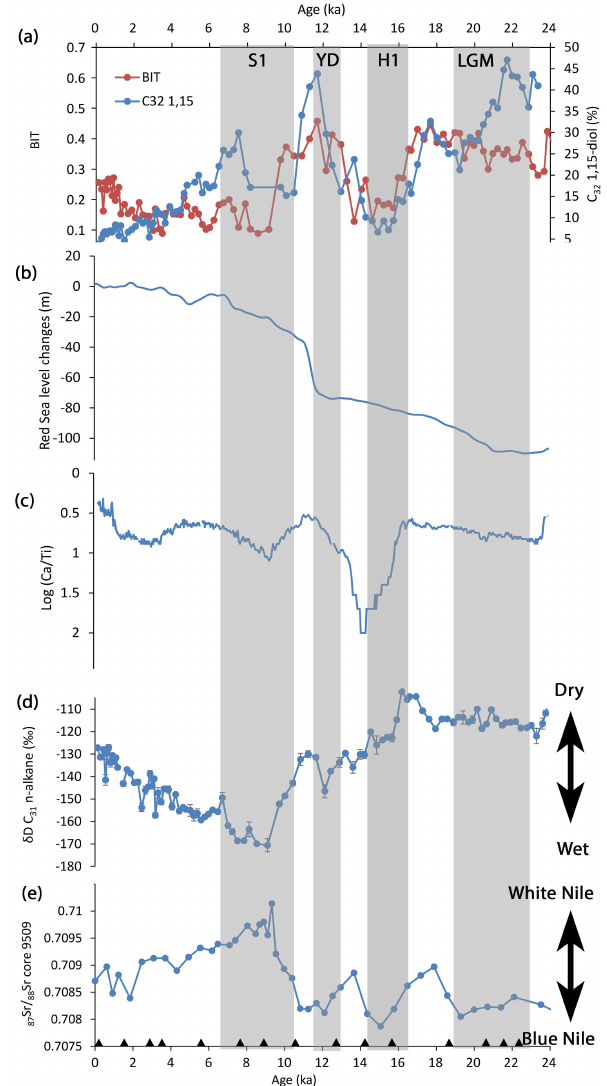
Figure 4. Organic and lithologic proxy records for core GeoB7702- 3 and core 9509. (a) BIT index indicating soil and riverine input (Castañeda et al., 2010) and F C321 , 15 tracing riverine input (b) Red Sea Level changes (Grant et al., 2014) (c) log(Ca / Ti) indicating terrestrial input (Castañeda et al., 2016), (d) reconstruction of δ D precipitation based on leaf wax n-C 31 alkane (Castañeda et al., 2016), (e) 87 Sr / 86 Sr signatures of the sediment core 9509 (off- shore of the Israeli coast) document changes in riverine influence (Box et al., 2011). The grey bars show the sapropel layer (S1), YD, H1, and the Last Glacial Maximum (LGM). Black triangles indicate 14 C AMS dates (from Castañeda et al.,